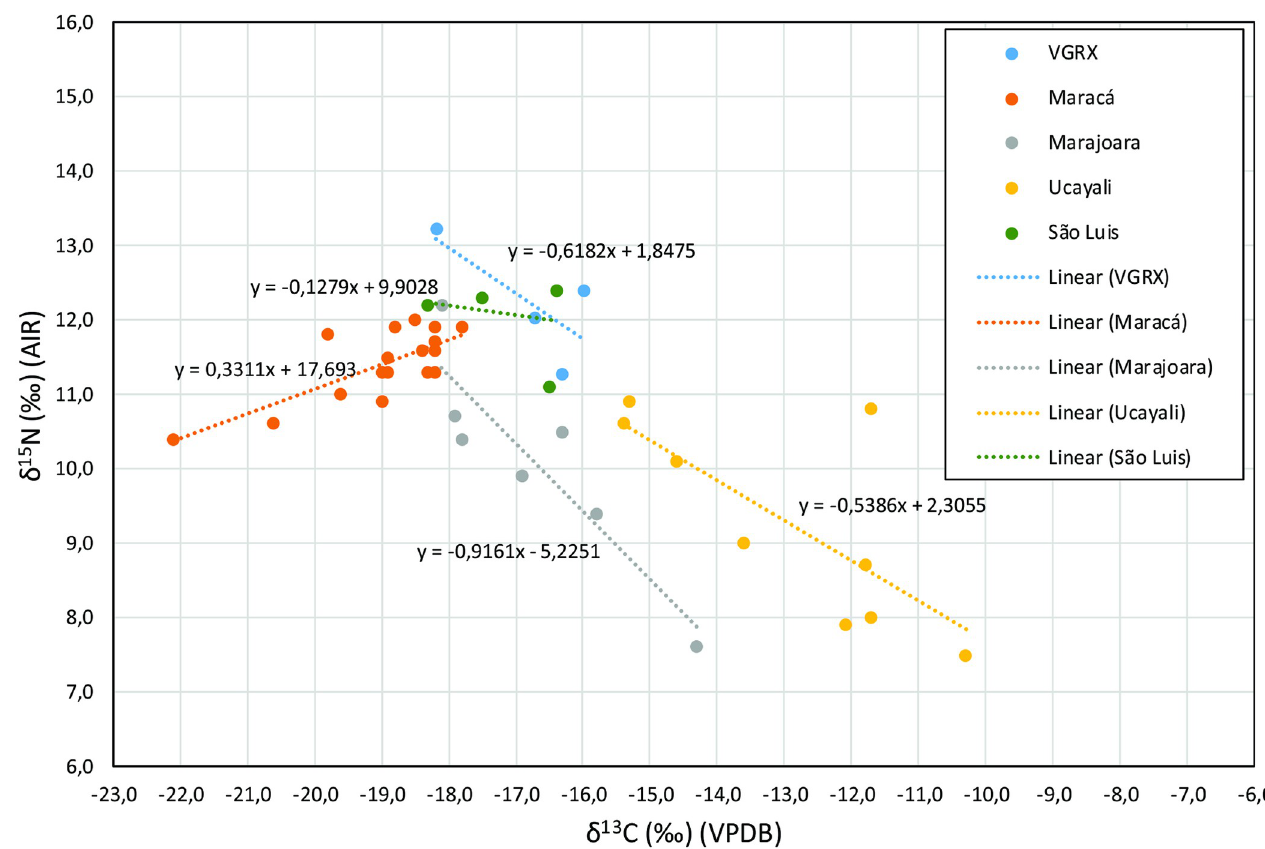
Fig 7. δ 13 C co and δ 15 N values of archaeological human bones from VGRX, Marajo´, Maraca´, S ã o Luis and